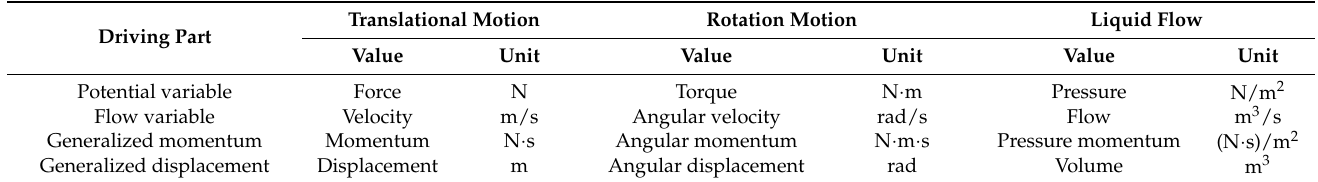
Table 1. The physical meaning of the four generalized